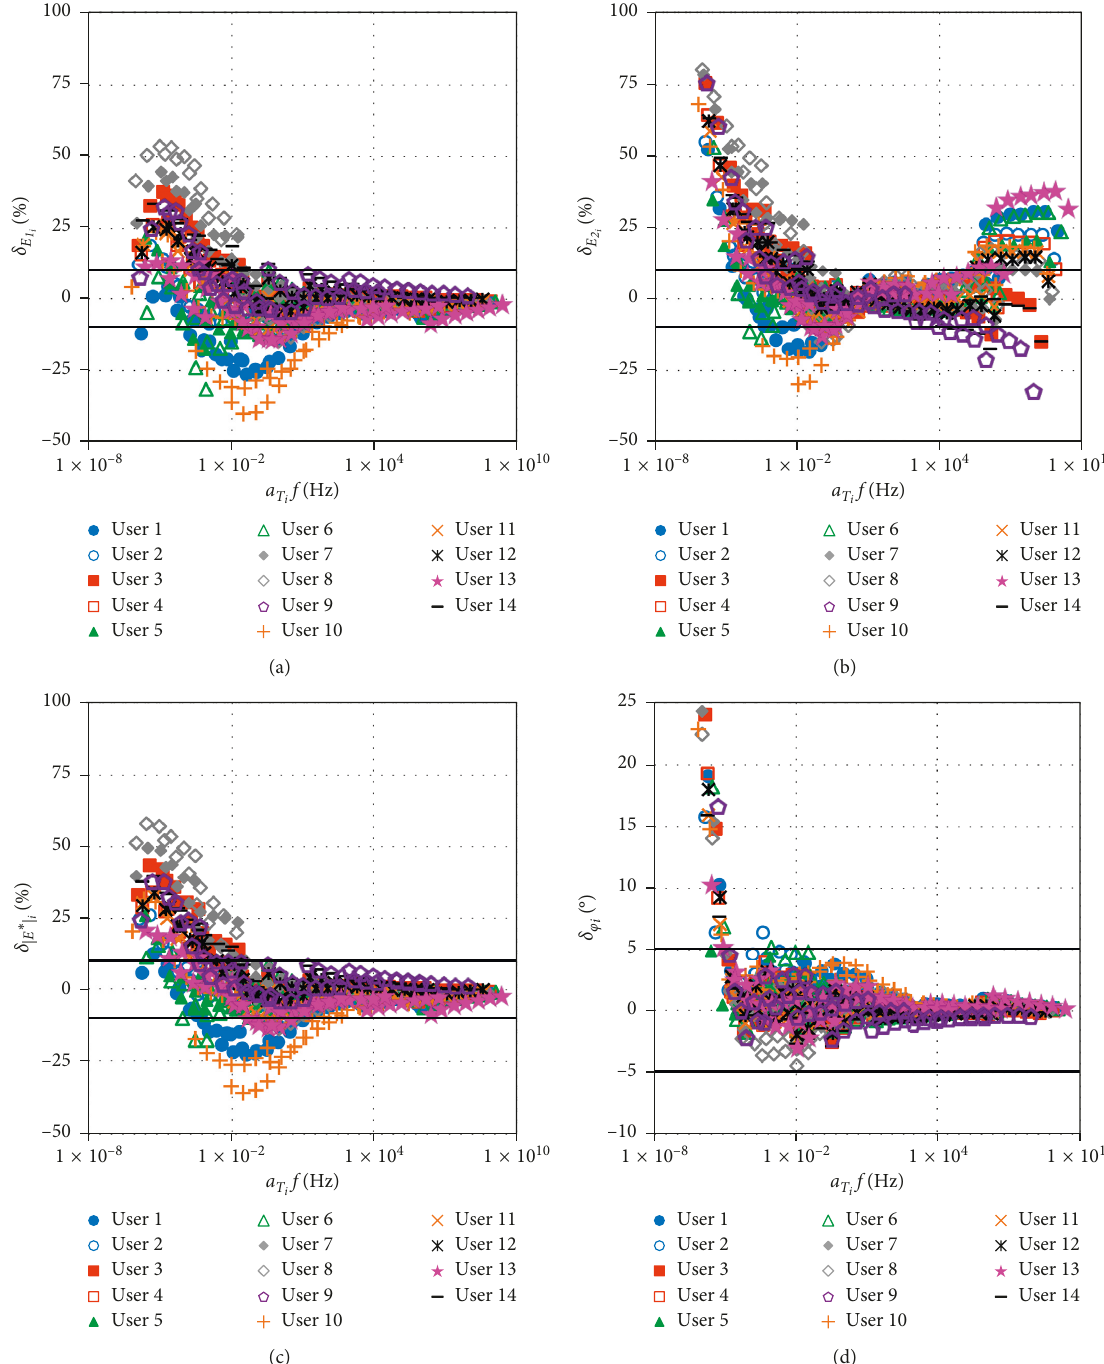
Figure 10: Errors between 2S2P1D simulations of all users and experimental data for the bituminous mixture ( T E E E (c) and absolute error for φ (d). Bold lines represent 10% and 5 ° limits for, respectively, relative and absolute 1 (a), 2 (b), and | | ∗